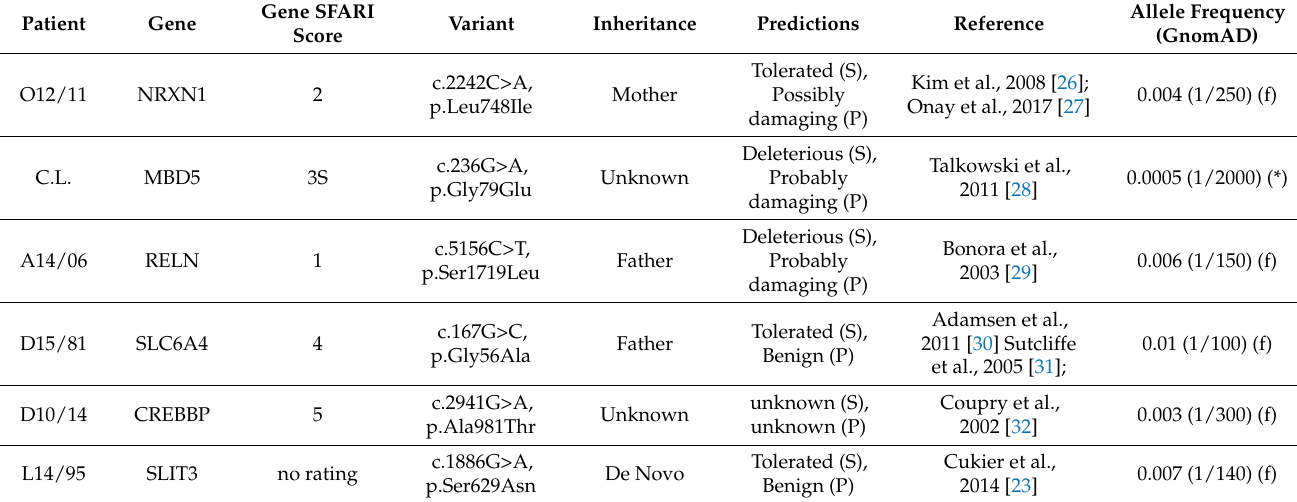
Table 6. Variants already described in other